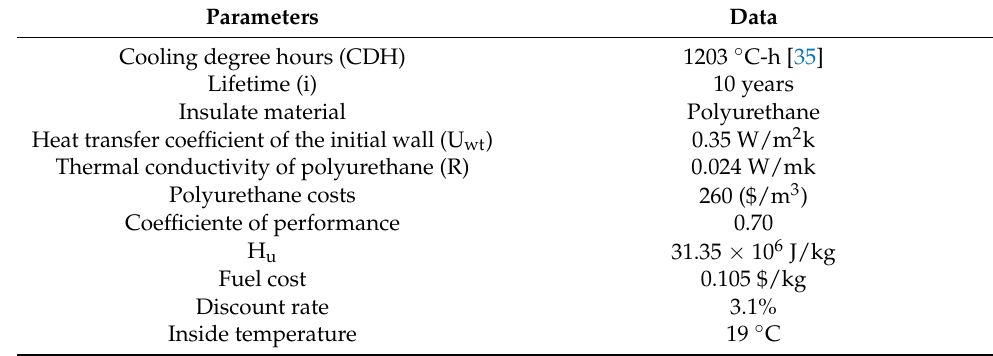
Table 14. The container parameters used for base Miguel de Cervantes in Marjayun (Lebanon).